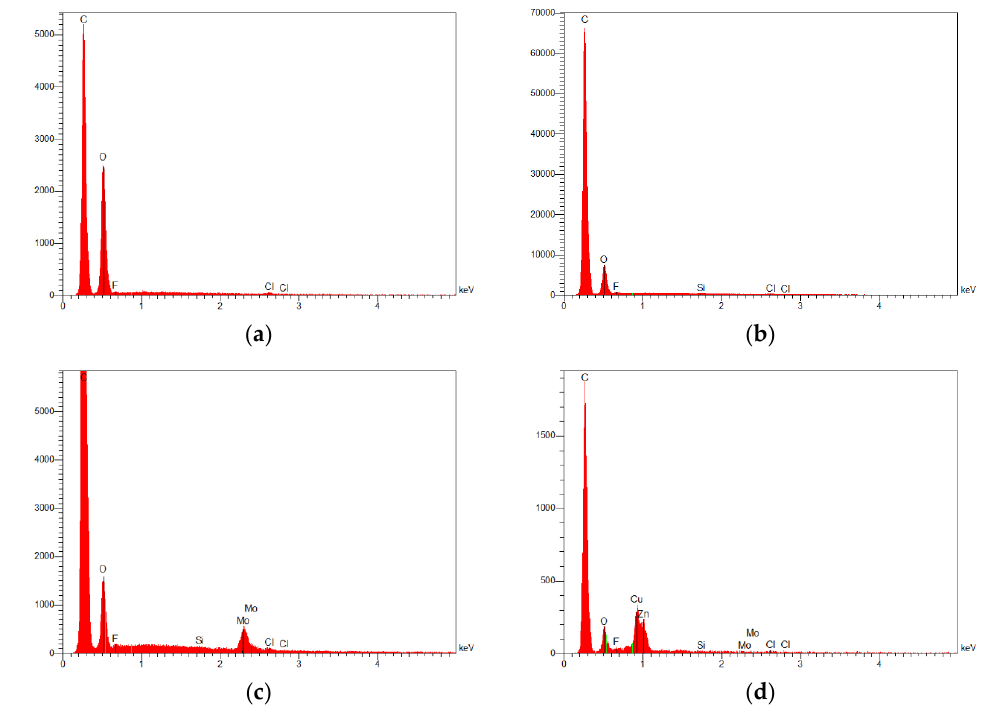
Figure 7. Energy Dispersive X-Ray Analysis (EDX) performed on large areas: ( a ) PLA and ( b ) PLC filaments, and focused on particles with typical areas of ( c ) 1.7 µm 2 and ( d ) 2.2 µm 2 .